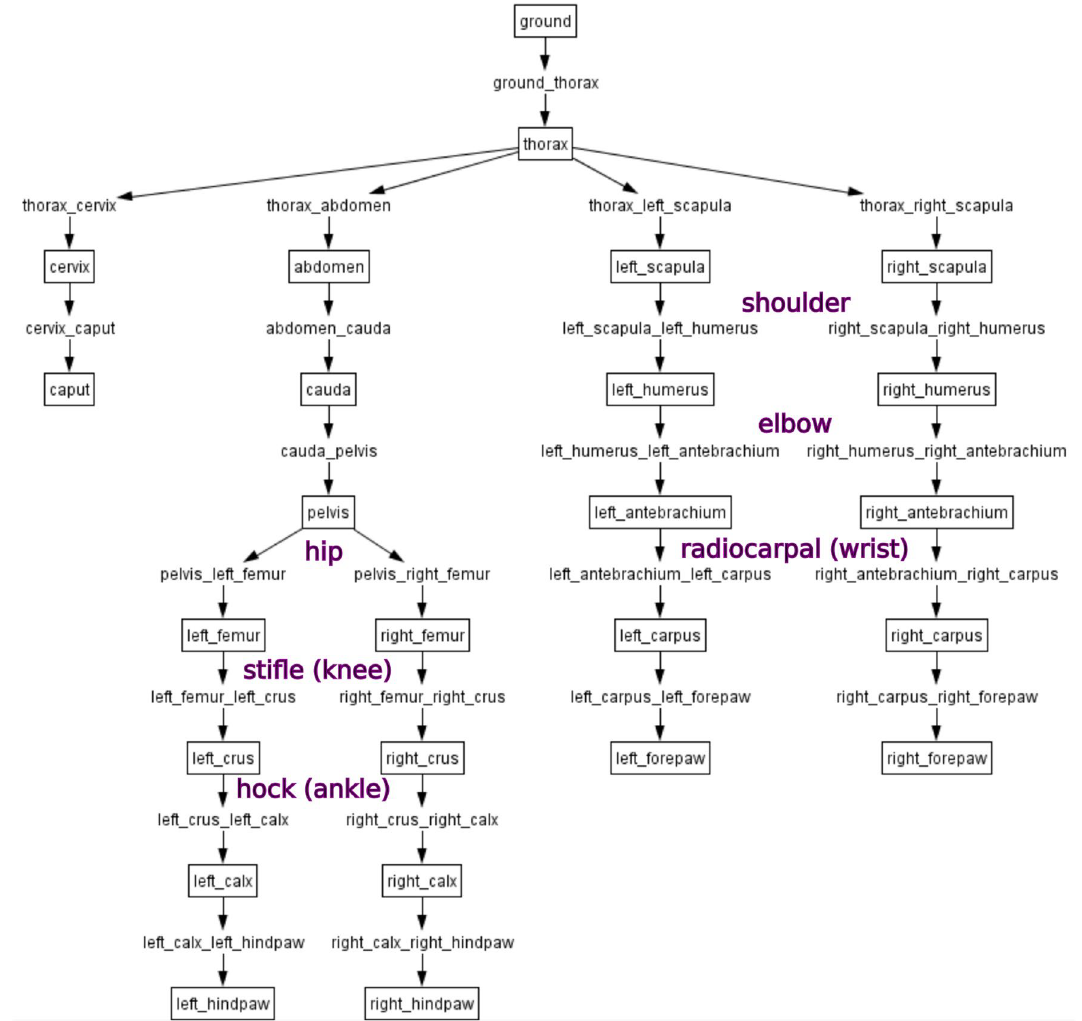
Figure 6. Topology of the segments (boxes) and joints (arrows) of the whole Beagle (BE) model using the software package OpenSim 28,29